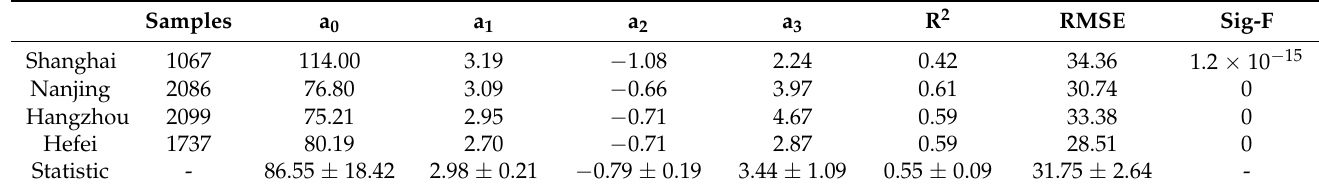
Figure 4. Relationship between various levels of daily O 3 and air temperature (AT: black), sunshine duration (SD: red) or relative humility (RH: blue) over four capital cities ( a ) Shanghai, ( b ) Nanjing, ( c ) Hangzhou, ( d ) Hefei in the Yangtze River Delta. Table 1. Statistics of multiple linear regression for daily O 3 and meteorological